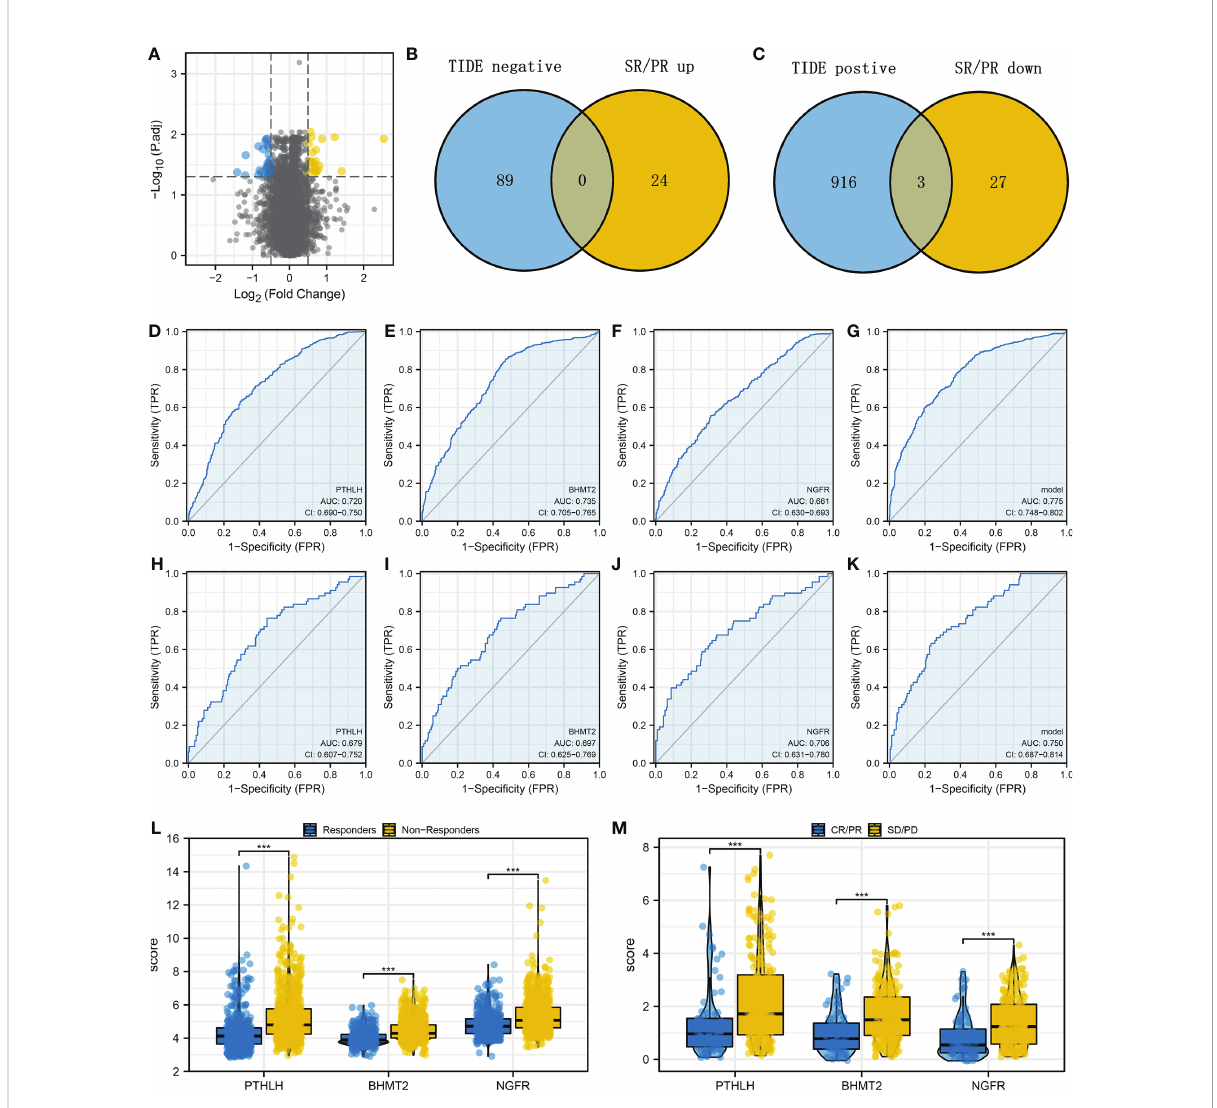
FIGURE 4 Identi fi cation of the PTHLH, BHMT2, and NGFR (A) Limma package was used for DEG analysis between the SD/PD and CR/PR patients with the threshold of |logFC| > 0.5 and adjusted p -value < 0.05. (B) Intersection of the genes negatively correlated with TIDE score and upregulated in CR/PR (LASSO logistics regression). (C) Intersection of the genes positively correlated with TIDE score and downregulated in CR/PR (LASSO logistics regression). (D – G) Performance of PTHLH, BHMT2, NGFR, and the logistics model in predicting bladder cancer immunotherapy (combined cohort). (H – K) ROC curves were used to evaluate the performance of PTHLH, BHMT2, NGFR, and the logistics model in predicting bladder cancer immunotherapy (IMvigor210 cohort). (L) The level of PTHLH, BHMT2, and NGFR in immunotherapy responders and non- responders. (M) The level of PTHLH, BHMT2, and NGFR in immunotherapy SD/PD and CR/PR patients. ***P <